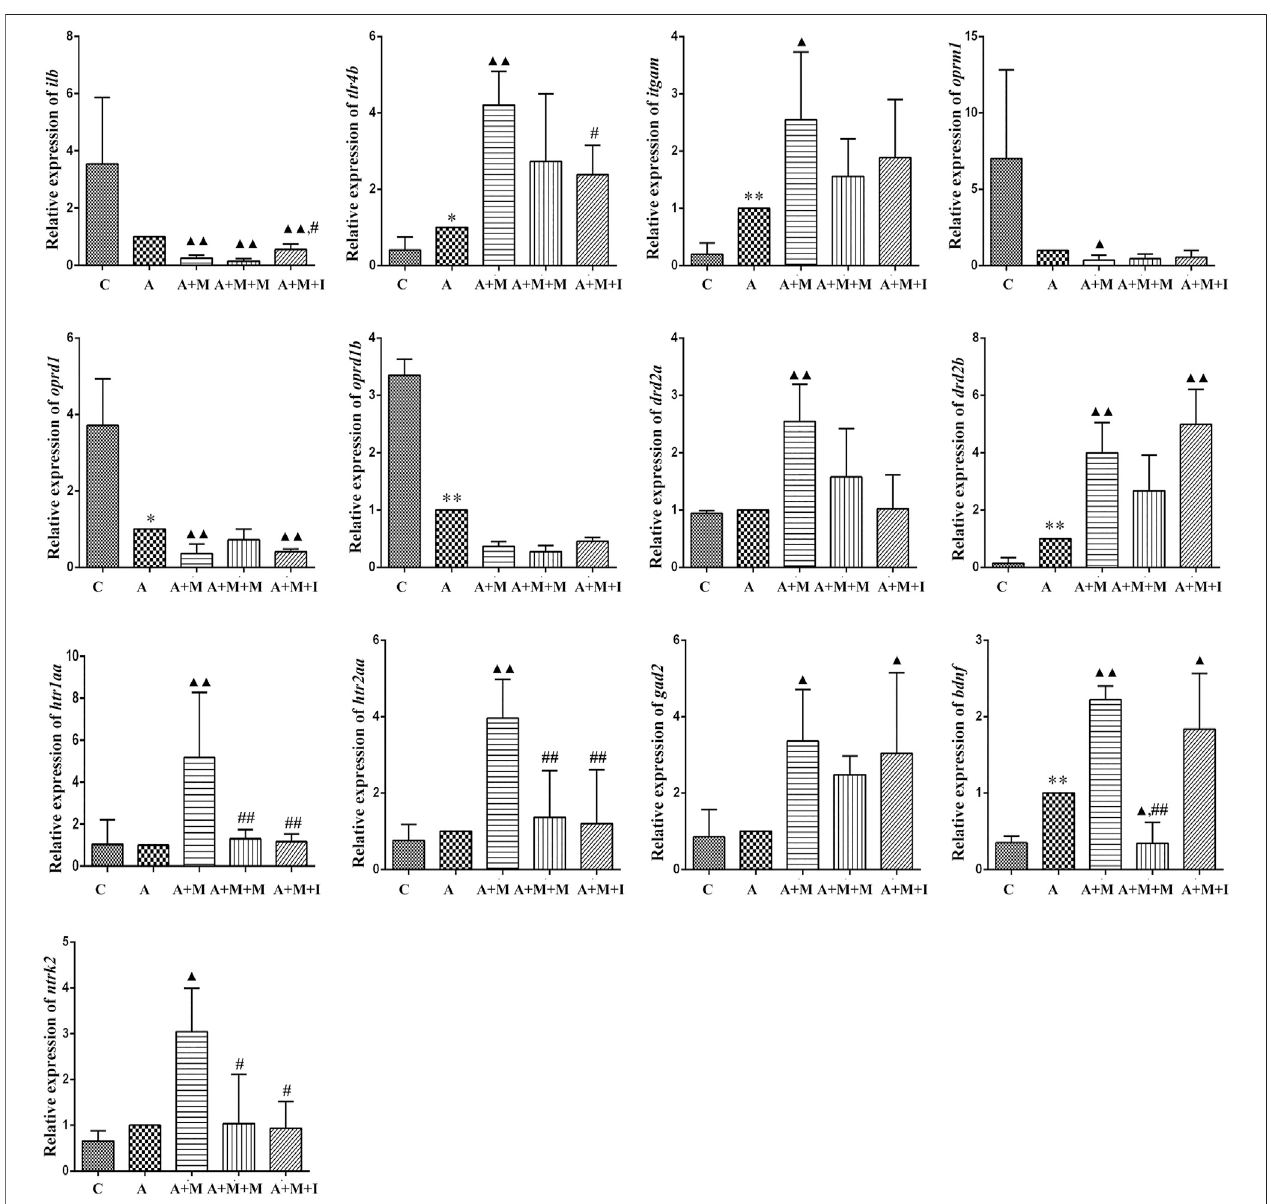
FIGURE 14 | qPCR analysis of il1b , tlr4b , itgam , oprm1 , oprd1 , oprd1b , gad2 , drd2a , drd2b , htr1aa , htr2aa , bdnf , and ntrk2 expression in the zebra fi sh brain ( n (cid:2) 3). * p < 0.05, ** p < 0.01 vs the C group; # p < 0.05, ## p < 0.01 vs the A + M group; ▲ p < 0.05, ▲▲ p < 0.01 vs the A group. C: control group; A: antibiotic group; A + M: antibiotic + morphine group; A + M + M: antibiotic + morphine + methadone group; A + M + I: antibiotic + morphine + isorhynchophylline group.